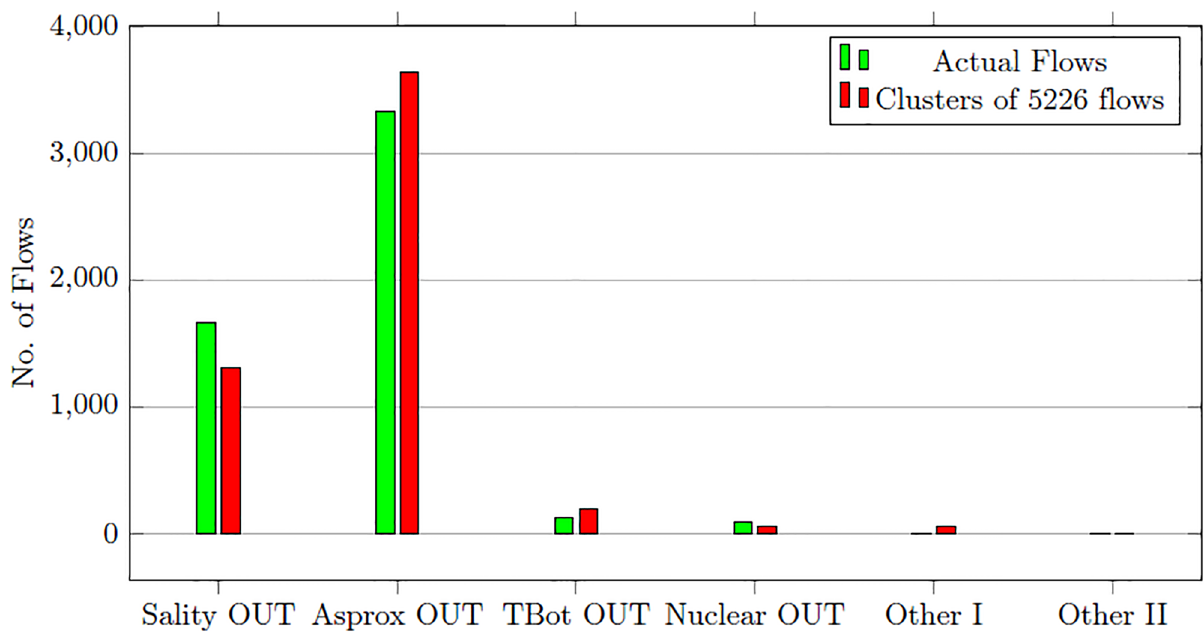
Fig 7. Malware and APT clustering results